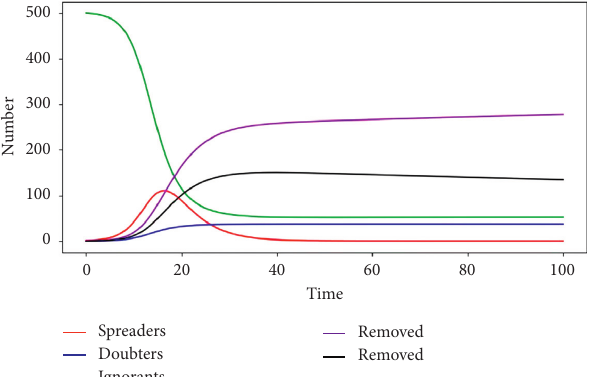
Figure 4: The stability of φ ∗ in system (1) with R